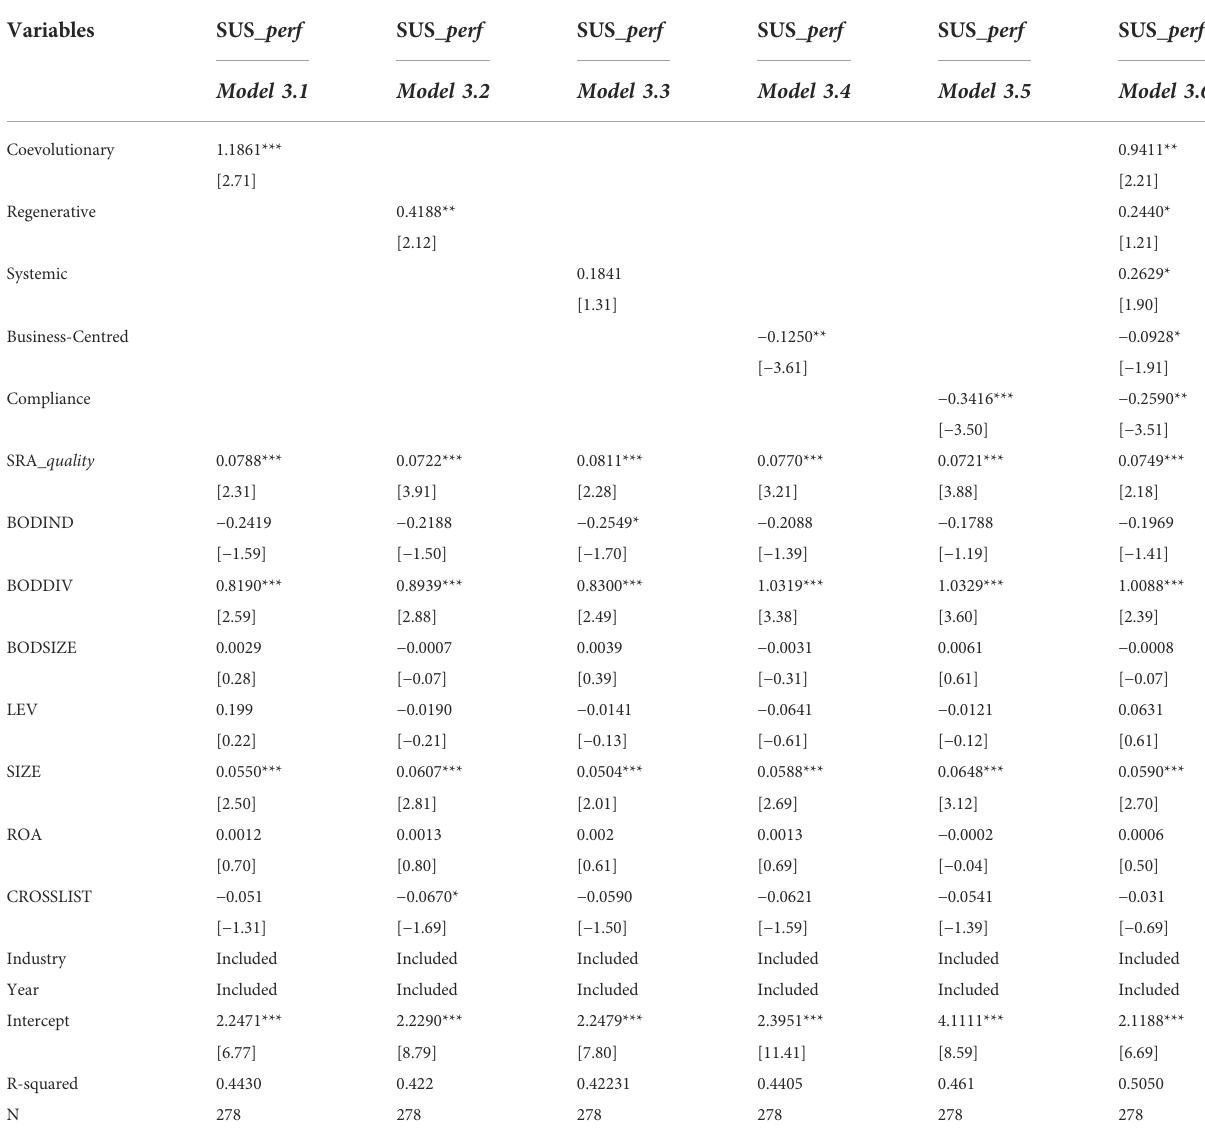
TABLE 3 Impact of sustainability communicative actions on sustainability